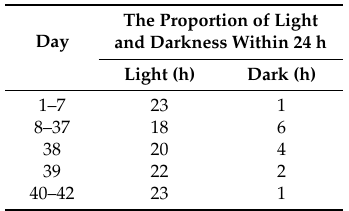
Table 1. Light regime in the chicken